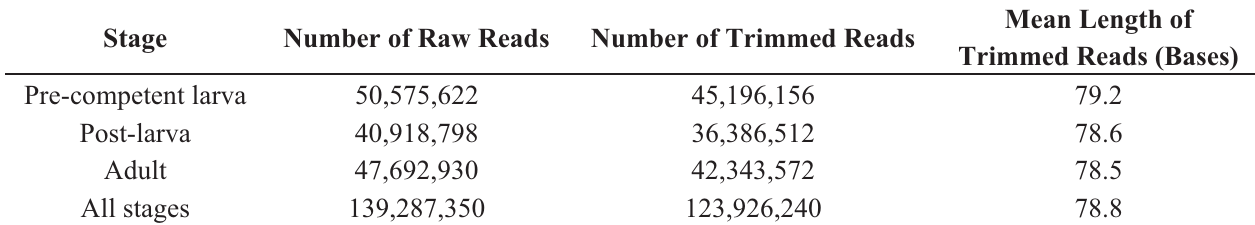
Table 1. Summary statistics for the mRNA reads before and after trimming.